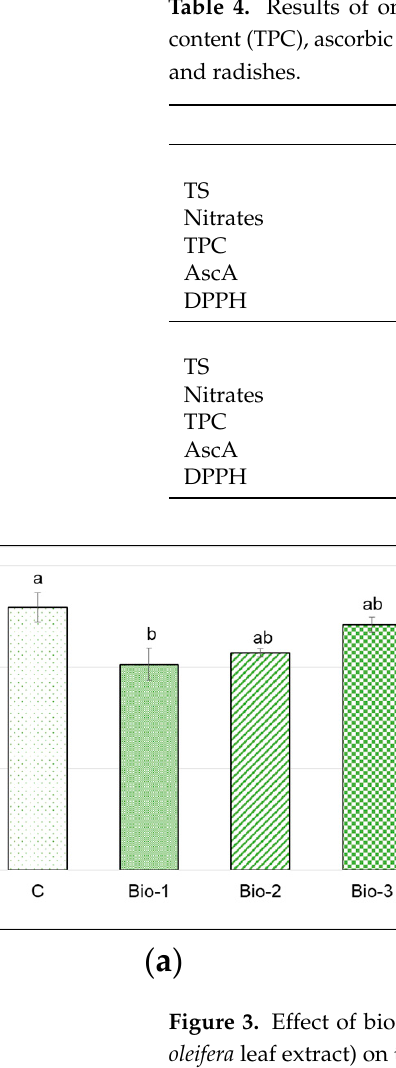
Table 4. Results of one-way ANOVA for total sugars (TS) and nitrates content, total phenolic